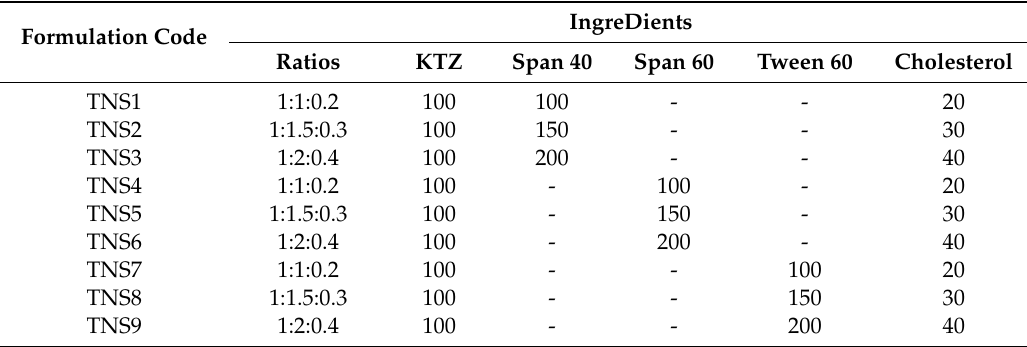
Table 8. Formulations of KTZ niosomes. Ratios (KTZ: surfactant: cholesterol). All ingredients were